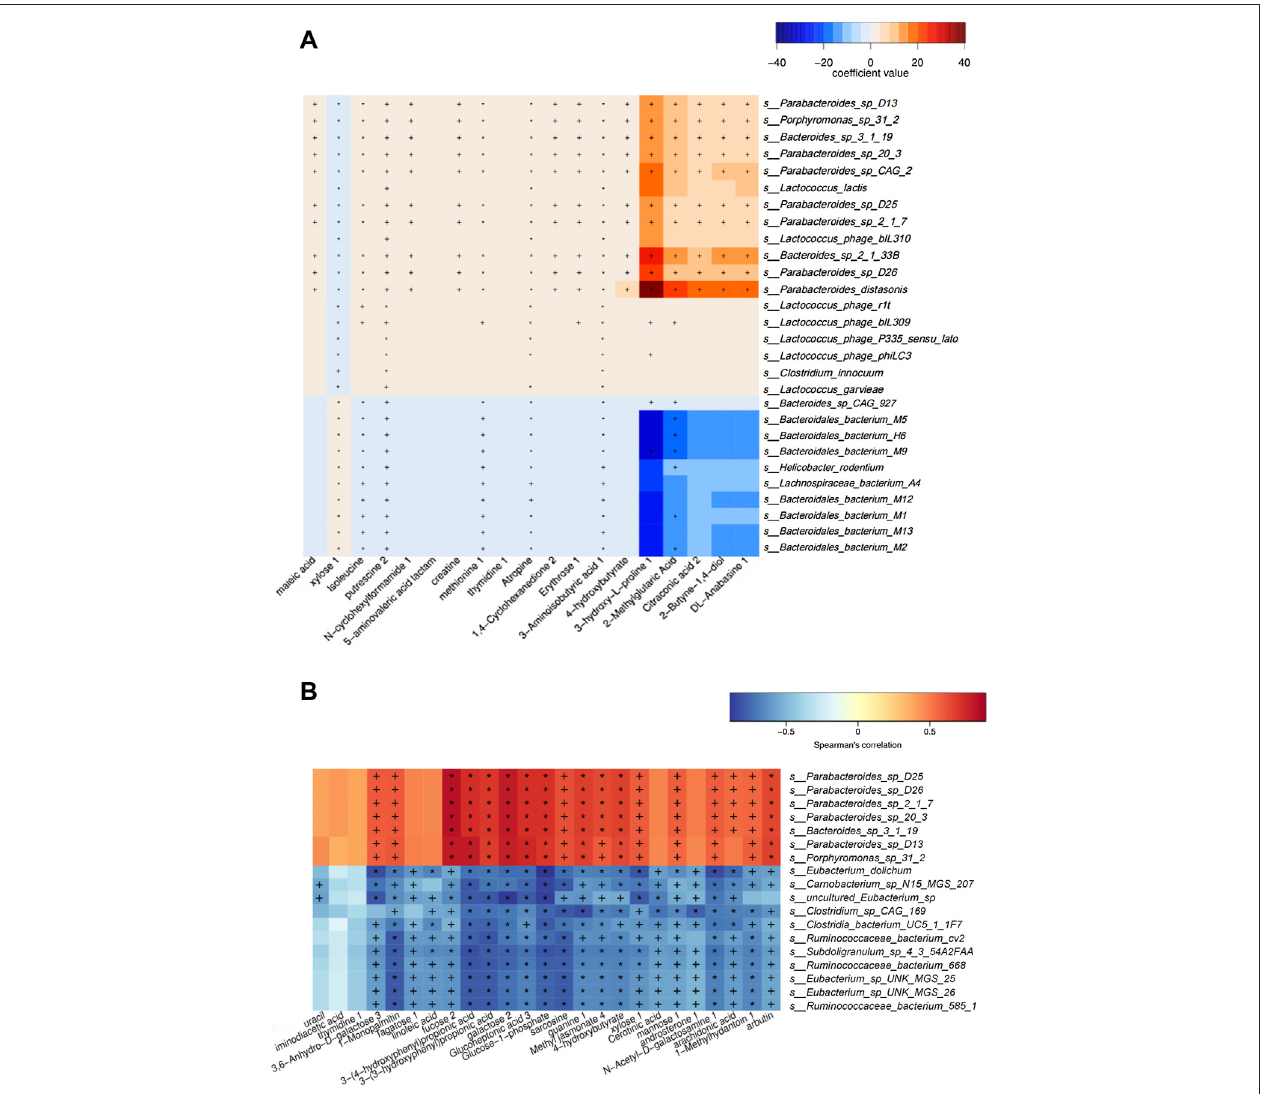
FIGURE 6 | Association analysis between metagenomics and metabolomics. (A) Maslin analysis heat map of bacteria and metabolites (NC group vs. MC group). +q < 0.05; *q < 0.01. (B) Heat map of correlation between differential species and differential metabolites (BER group vs. MC group). + p < 0.05; * p < 0.01.